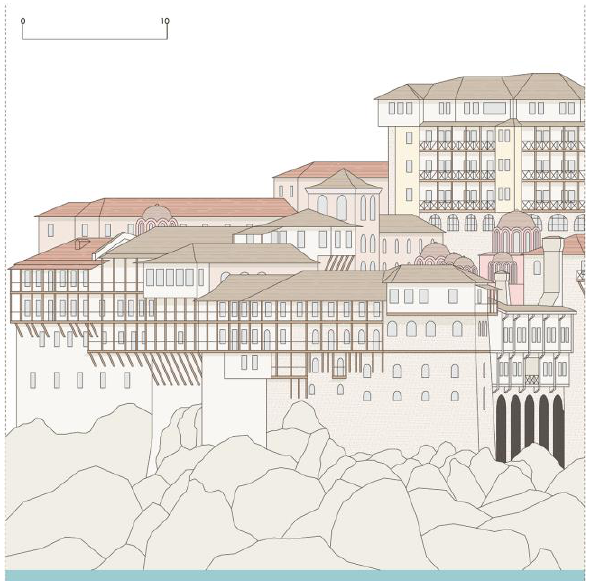
Figure 24 . The Monastery of St. Pantaleimon. Detail of the western